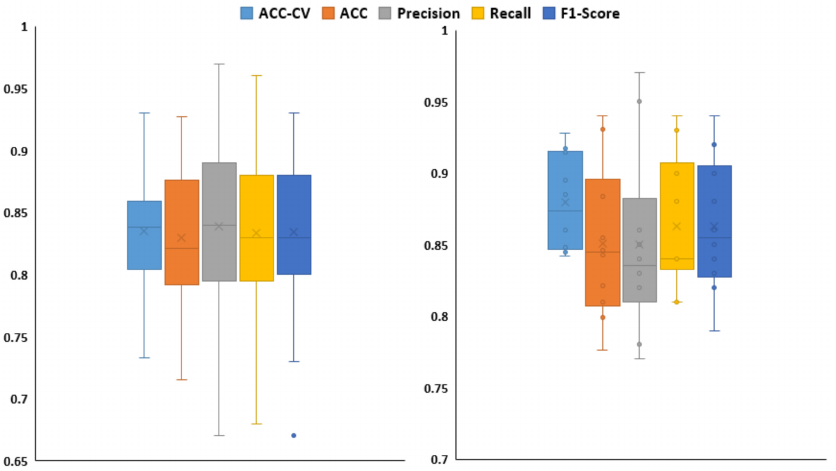
Figure 2. Distribution of performance metrics obtained for all models for targets ( Left ) and off-targets ( Right ). ACC-CV: accuracy values obtained in cross validation analysis. All other metrics (accuracy, precision, recall and f1-score) were obtained for the external